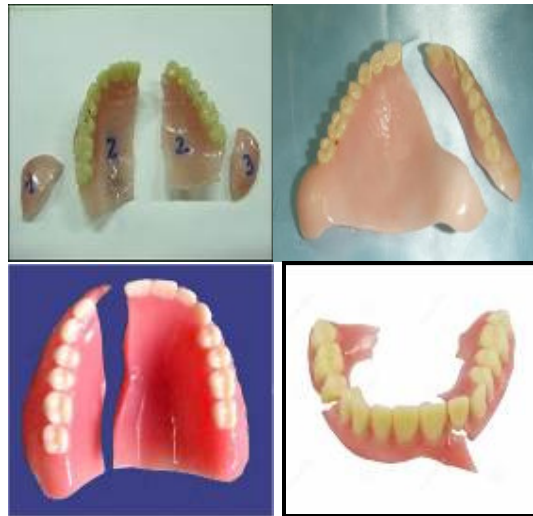
Fig. 1. Show the Impact Fracture in the Prosthetic Dentures.